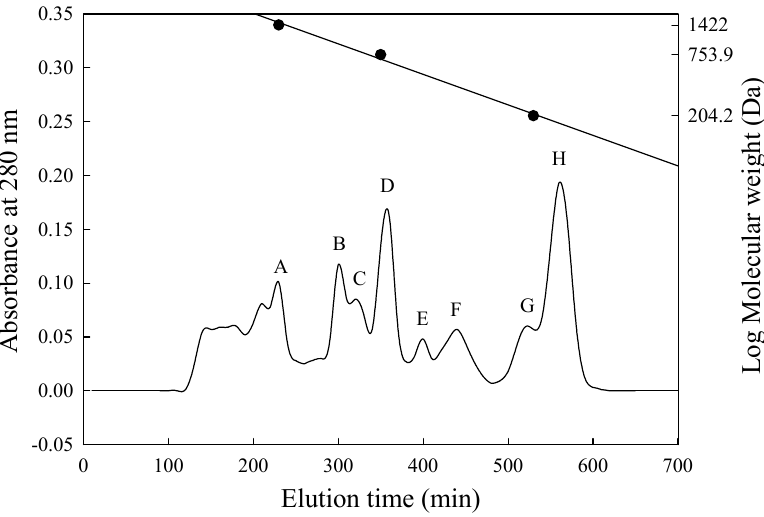
Figure 2. Peptides separate from PX-5G on a Sephadex G-25 column. ● Standards: The MWs of Bacitracin, penta-L-phenylalanine and L-tryptophan were 1422, 753.9 and 204.2 Da, respectively. PX-5G was separated into 8 fractions designated as A-H.